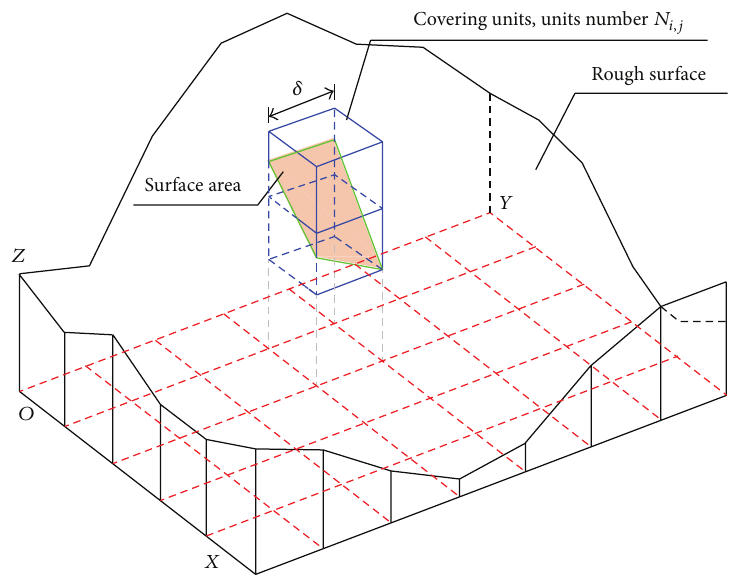
Figure 5: Schematic view of the cubic covering method (a redraw version according to [13]). Table 1: Total numbers 𝑁 ( 𝛿 ) of required cubes and the measurement scales 𝛿 , according to the CCM. 𝛿 /mm Tension-induced fracture surfaces Compression-induced fracture